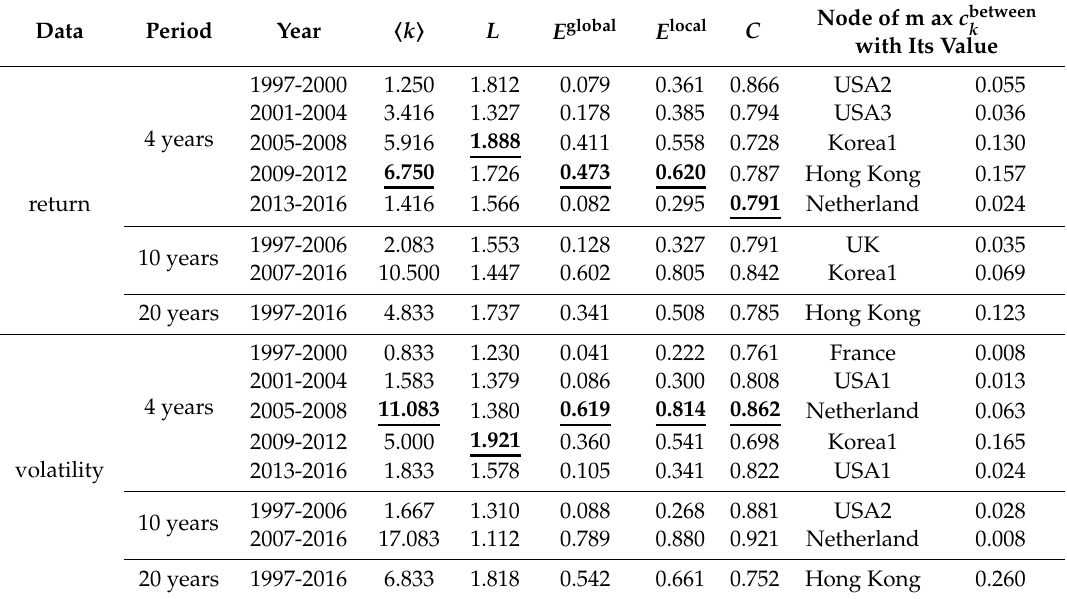
Table 3. Network properties of global 24 stock markets generated by DCCA methodology Data Period Year (cid:60) k